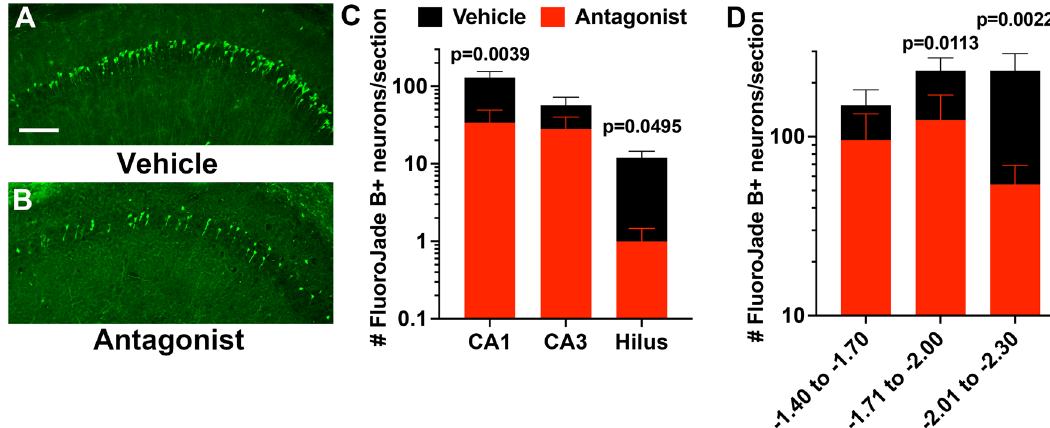
Figure 6. CCR2 antagonism relieves neuronal injury after SE. FJB staining in hippocampal tissue sections three days after KA SE shows reduced numbers of injured CA1 hippocampal neurons in CCR2 antagonist-treated mice ( B ) compared to vehicle-treated mice ( A ). Scale bar is 100 μm. ( C ) Plot of the number of FJB + neurons in hippocampal cell layers reveals fewer damaged neurons in mice subject to the CCR2 antagonist (CA1 veh n = 20; CA1 antag n = 18, one statistical outlier removed; CA3 veh n = 19 statistical outlier removed; CA3 antag n = 18, statistical outlier removed; hilus veh n = 19 statistical outlier removed; hilus antag n = 18, statistical outlier removed). The outliers, if retained, would not have changed the interpretation. Kruskal–Wallis test followed by Dunn’s multiple comparisons tests found significant differences between treatments in the CA1 and hilus, but the reduction in FBJ+ neurons did not reach significance in the CA3 region ( p = 0.808). Bars indicate mean ± SEM. ( D ) Plot of the total number of FJB+ neurons in the hippocampus segmented across Bregma coordinates. Kruskal–Wallis test followed by Dunn’s multiple comparisons tests found significant differences between treatments in two caudal regions, but the reduction in FBJ+ neurons did not reach significance in the extreme rostral region ( p = 0.1767). Bars indicate mean ±